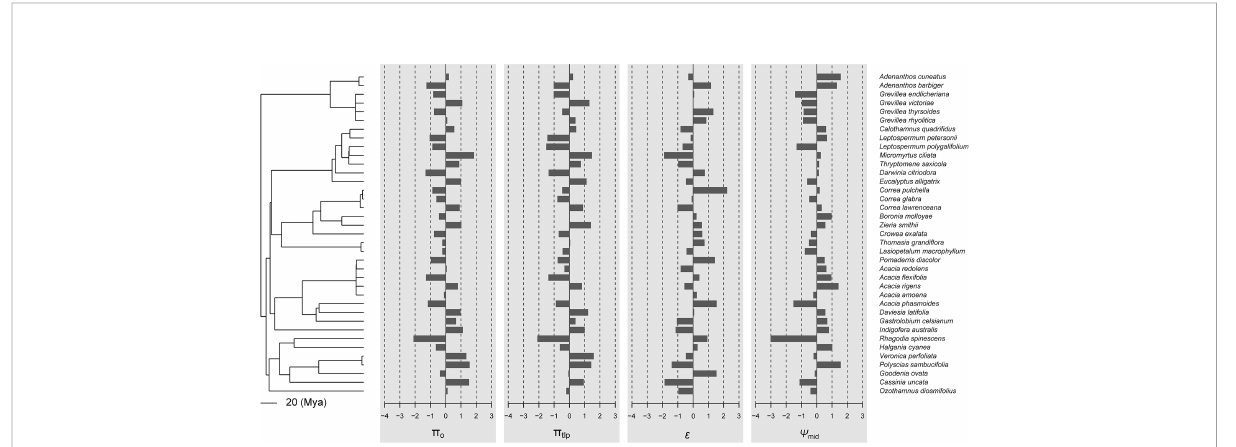
FIGURE 2 Data visualization of the four physiological traits ( p o , p tlp , ϵ , and Y mid ) mapped along the phylogeny of 37 shrub species. If these traits were phylogenetically conserved, closely related species should share similar bar lengths. By default, data are centered and scaled by trait.